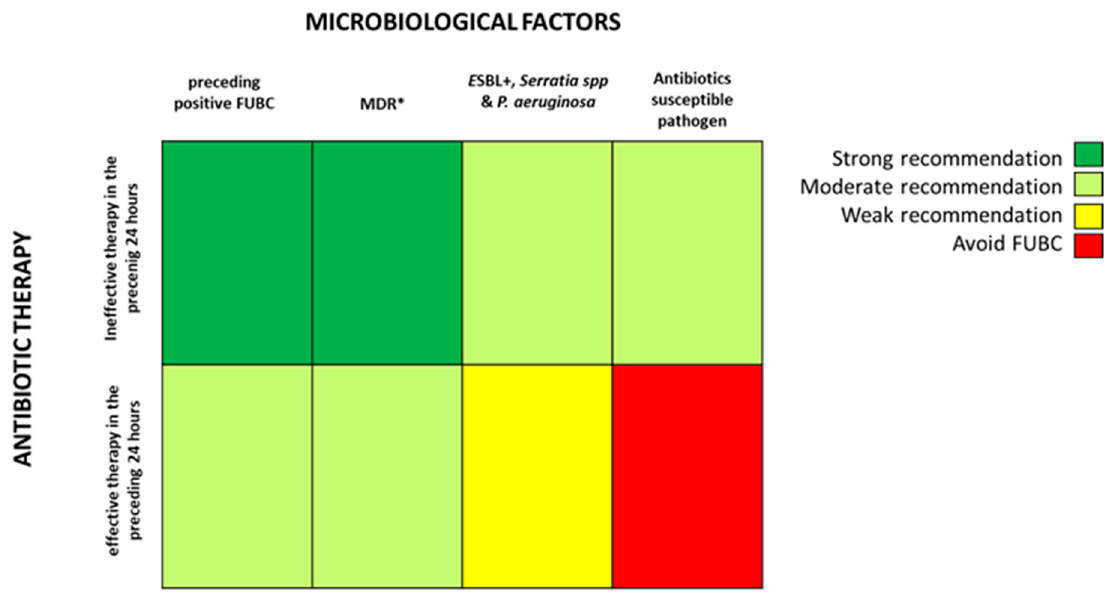
Figure 3. Analysis of recommendations for FUBC sampling in the setting of Gram negative bacteremia